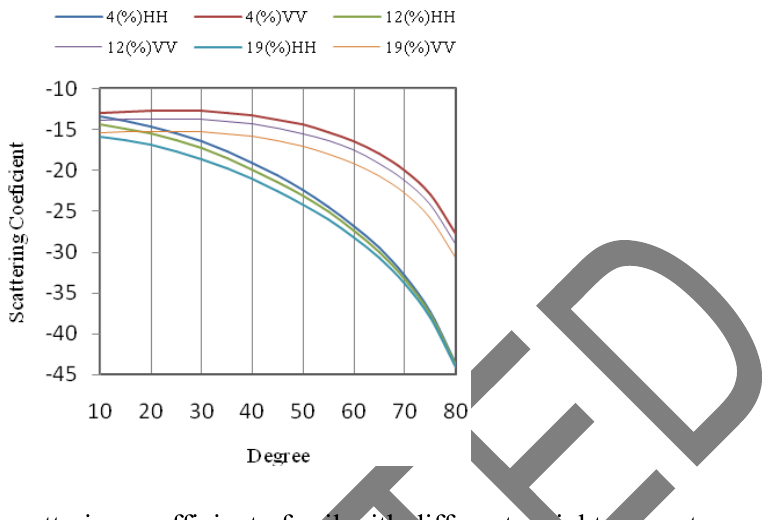
Figure 6. Variation of the scattering coefficient of soil with different weight percentages of diesel (5, 11 and 18) in respect to different look angles.